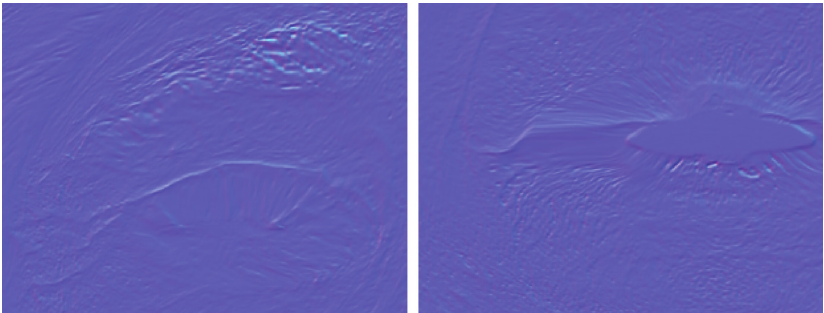
Figure 19. Tangent Space Normal Map Extracted from Diffuse Color Texture: Region Near the Eye (Left) and Region Near the Lip (Right). In a Normal Map, the Red, Green, and Blue Compo- nents of an Image Correspond to the x, y, and z Vectors of a Normal to the Surface of the